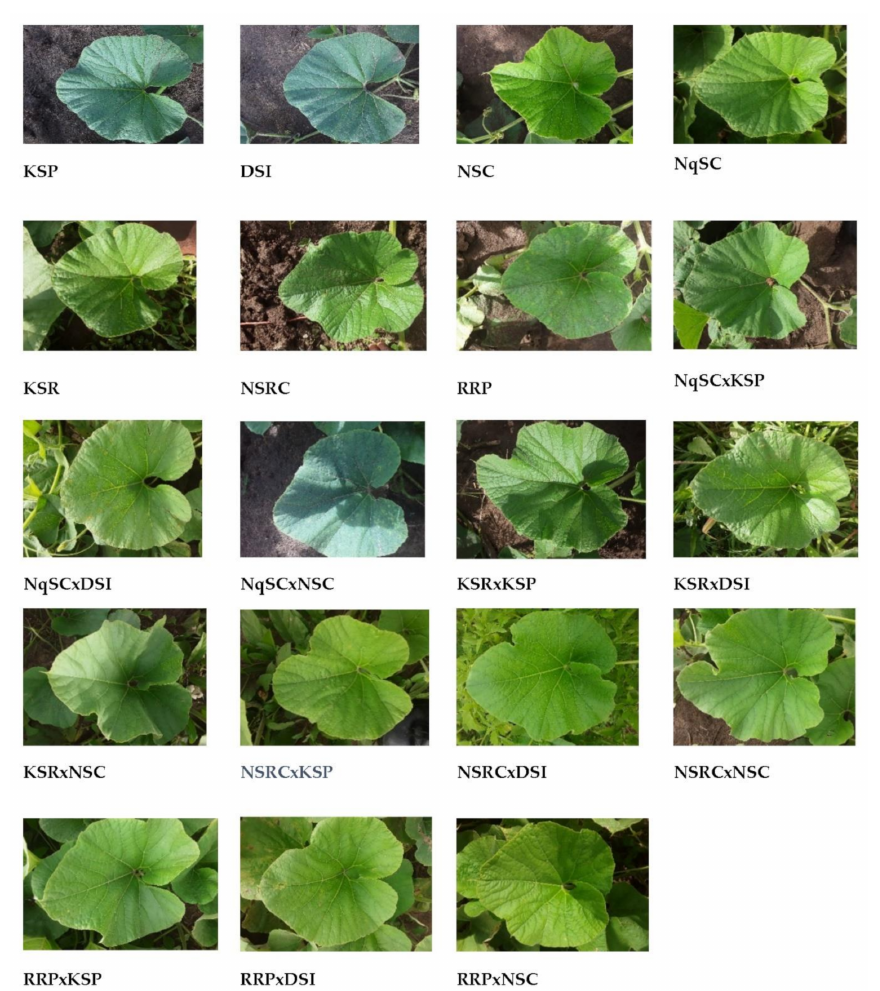
Figure 1. Diversity in leaf color and leaf margin among Lagenaria siceraria genotypes. Table 2. Description of Lagenaria siceraria genotypes according to the fruit and seed morphology.